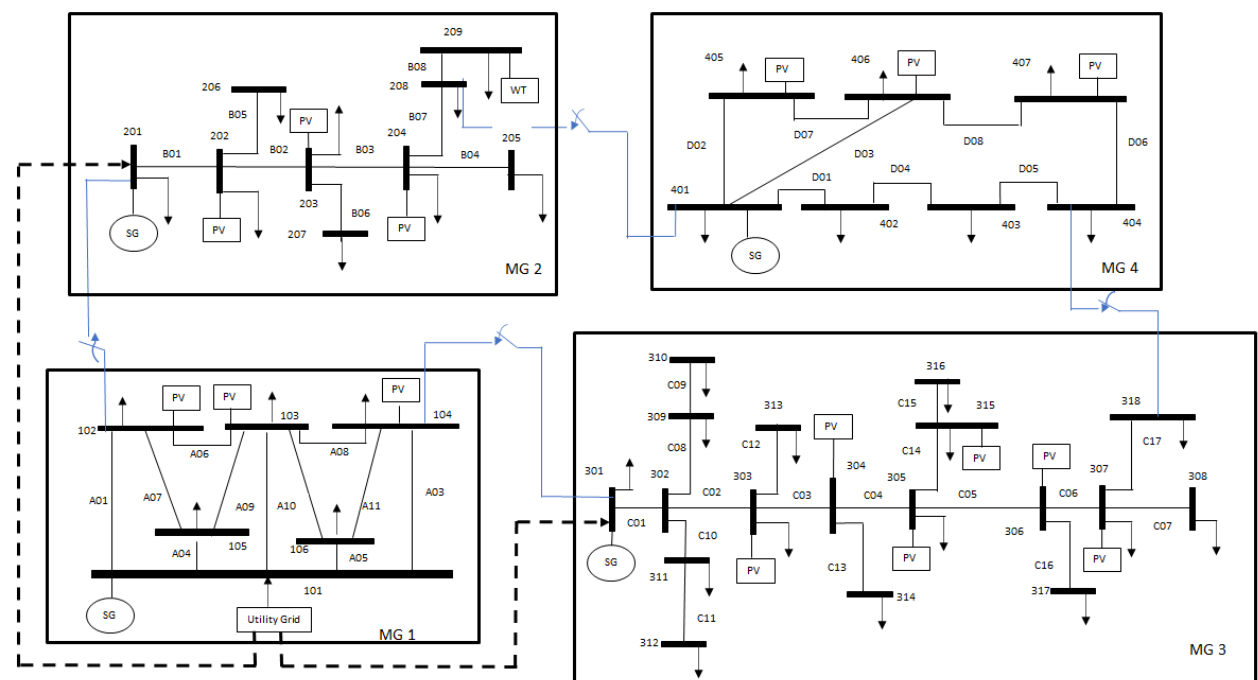
Figure 4. Single line diagram of the modified benchmark 4-MG test system [23]. Table 1. MG Generation and storage power capacity .